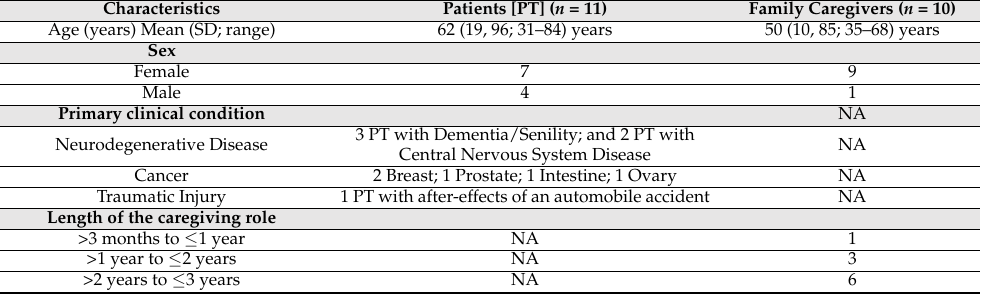
Table 1. Sample characteristics ( n = 21